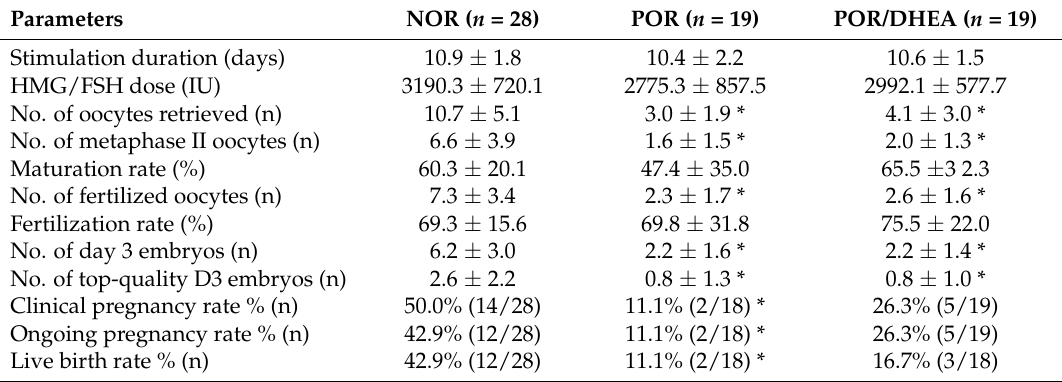
Table 2. Cycle characteristics and pregnancy outcome in the NOR, POR, and POR/DHEA groups. Parameters